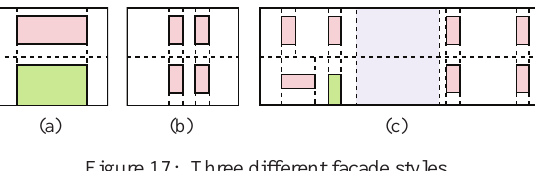
Figure 17: Three different fac¸ade styles